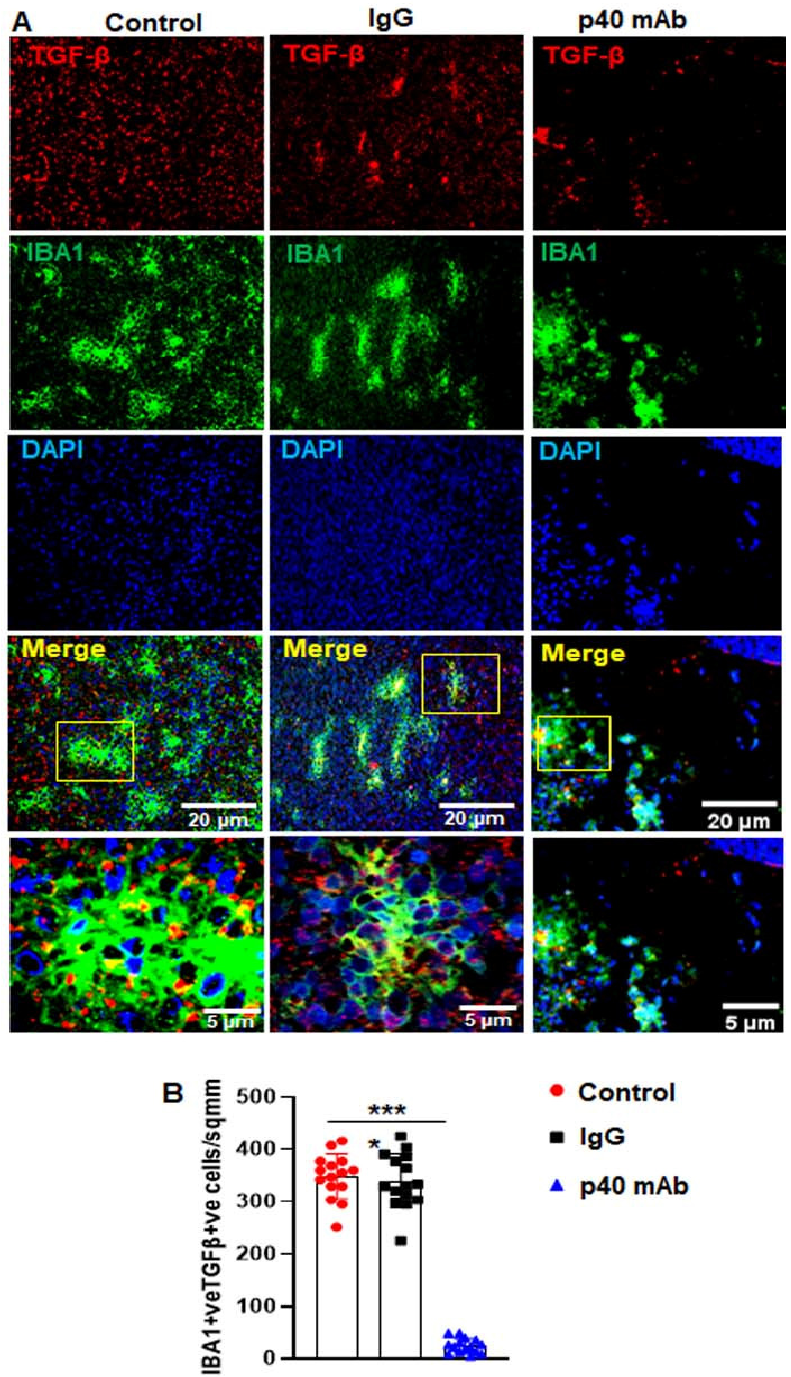
Figure 9. Neutralization of p40 by p40 mAb decreases the level of TGF β in TNBC tumor of PDX mice. Female 6–8 week old NSG mice were engrafted TNBC tumor in the flank. After about 4 weeks of engraftment, when tumors of PDX mice were 0.6–0.8 cm 2 in size, mice were treated with p40 mAb and hamster IgG at a dose of 2 mg/kg body wt once a week. After 2 weeks of treatment, tumor cross sections were double ‐ immunolabeled for Iba1 and TGF β ( A ). DAPI was used to stain nuclei. Cells positive for Iba1 and TGF β ( B ) were counted in one section (2–3 images per section) of each of five different mice per group. * p < 0.05; *** p < 0.001. 3.8. The p40 mAb Immunotherapy Is Not Toxic in PDX Mouse Model of TNBC Alanine aminotransferase (ALT) is probably the most widely used clinical biomarker of liver well ‐ being. Similarly, higher serum LDH than normal levels usually indicates tis ‐ sue damage. Therefore, to understand whether p40 mAb elicited any toxic effects, we measured LDH and ALT in serum of all groups of mice. While p40 mAb treatment in ‐ creased the level of serum LDH in PDX mice (Figure 10A) due to the death of TNBC tu ‐ mor, the level of serum ALT was markedly inhibited in p40 mAb ‐ treated PDX mice (Fig ‐ ure 10B), indicating that p40 mAb immunotherapy is not toxic in TNBC mice and that p40 mAb treatment reduces liver toxicity in TNBC mice. These results were specific as control IgG did not alter the level of either LDH or ALT in serum of PDX mice.